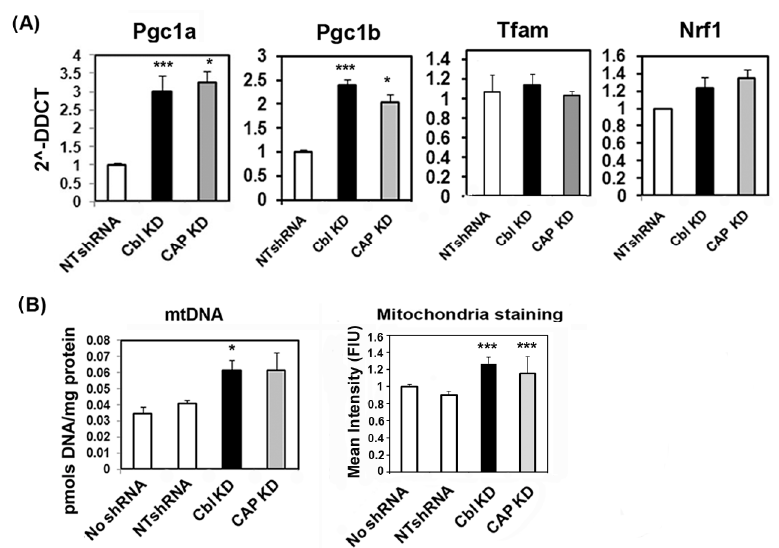
Figure 2. CBL or CAP depletion increases mitochondrial mass. ( A ) Quantification of mRNA of genes involved in mitochondrial biogenesis. Total RNA was obtained from C2C12 myotubes expressing NTshRNA or shRNAs for CBL or CAP. mRNA for each gene was determined by qPCR. Data show the relative expression to control cells; graphs are mean ± SEM values of n = 3–9 samples per group. ( B ) Assessment of mitochondrial mass. Quantification of mtDNA by qPCR (left graph) and quantitation of fluorescently labelled mitochondria with monomeric JC-1, arbitrary units (right graph). Graphs shows mean ± SEM of data from 5 experiments, each performed in triplicate biological samples. Statistical analysis: one-way ANOVA to NTshRNA-expressing cells. * indicates p < 0.05, and *** p <